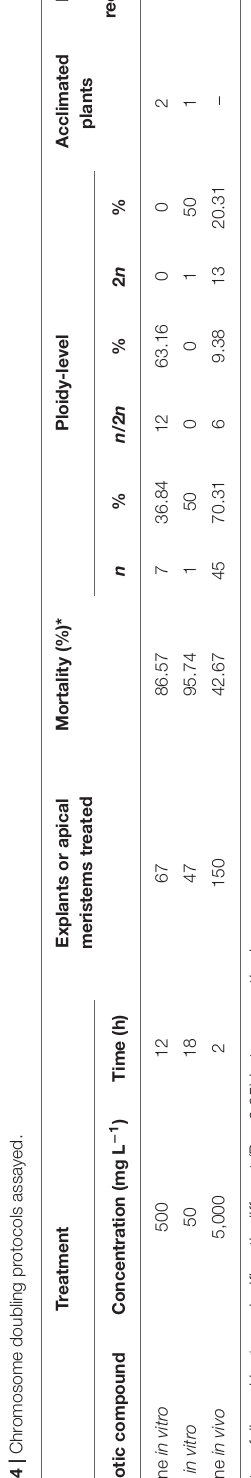
TABLE 3 | Parthenogenetic embryo rescue methods assayed for embryo detection and rescue. Method Melons Embryos Ratio of fruits